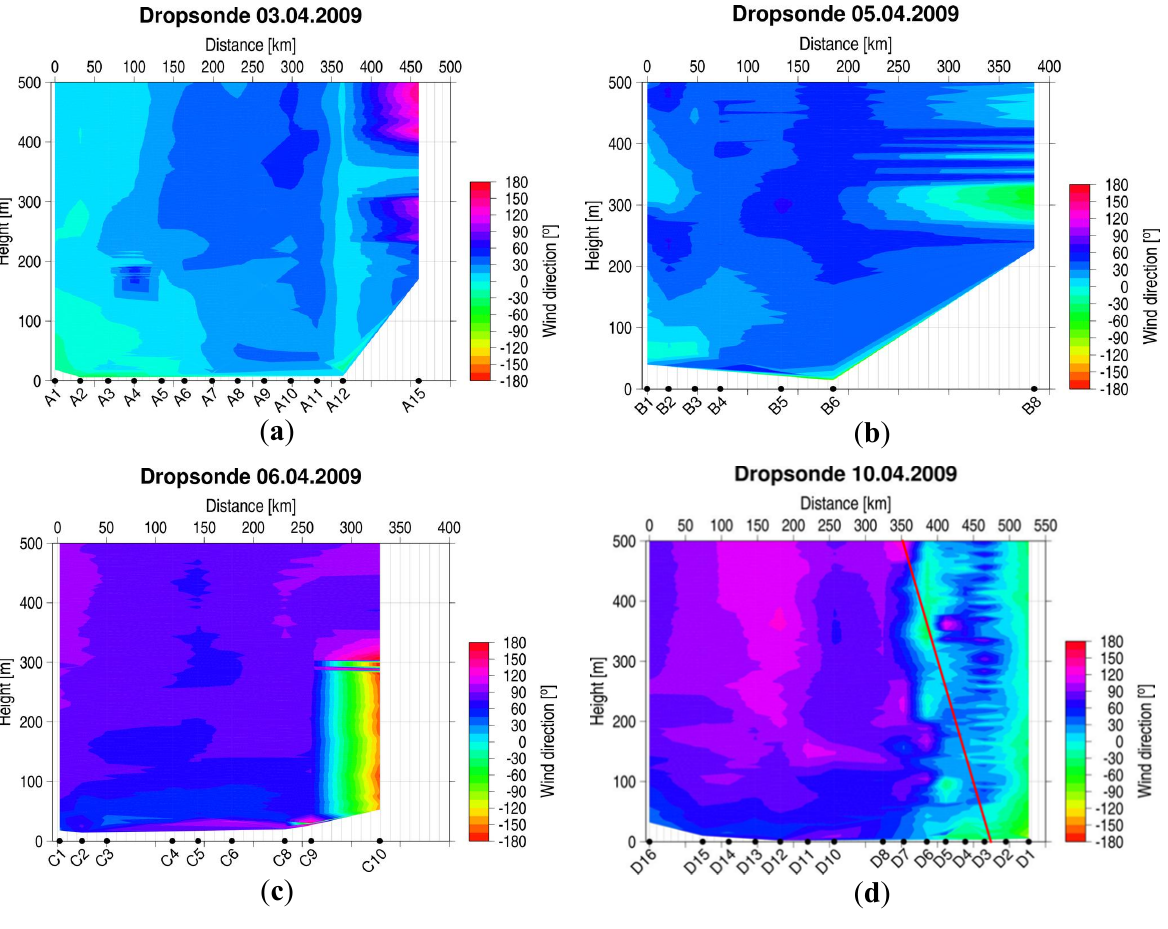
Figure 8. Dropsonde measurements of wind direction on 3 ( a ), 5 ( b ), 6 ( c ) and 10 April ( d ) 2009. The red line in panel d indicates the location of the front determined from the strongest horizontal temperature gradient.